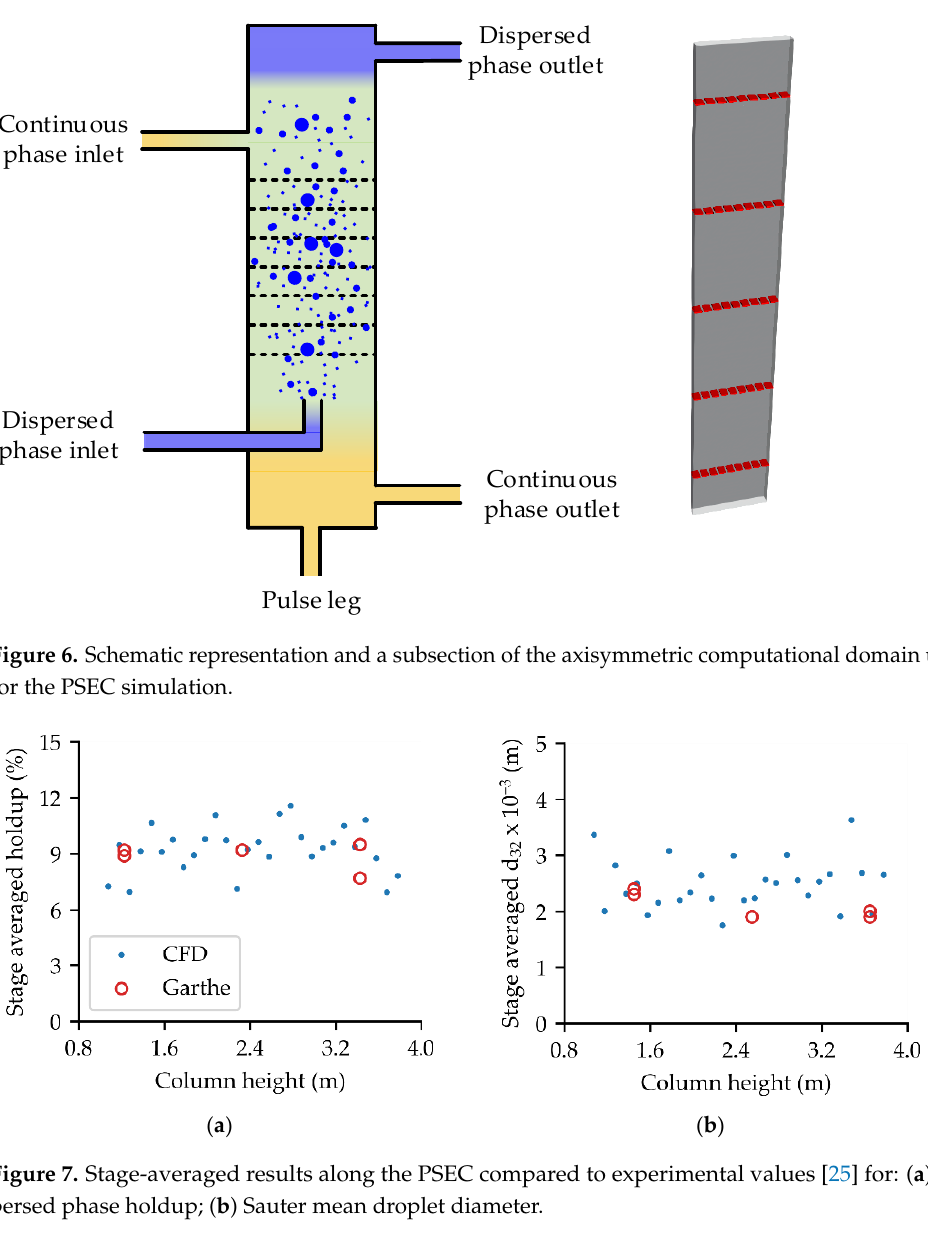
Figure 8. Counter-current extraction model block flow diagram. Three equations were used to give the continuous phase mass balance. For the aque- ous phase inlet, where 𝑛 = 𝑁 , Equation (17) was used. For all stages between the aqueous phase inlet and the organic phase inlet, where 0 < 𝑛 < 𝑁 , Equation (18) was used. For the organic phase inlet, Equation (19) was used: